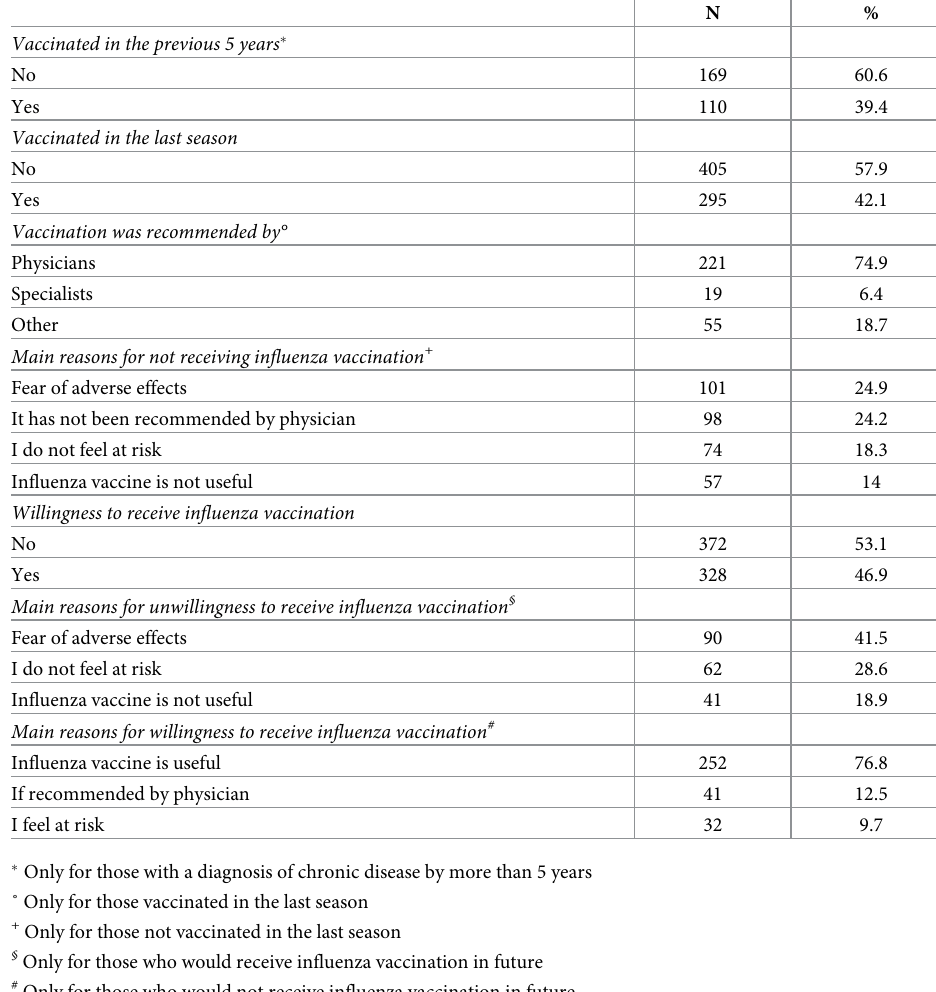
Table 3. History of influenza vaccination and willingness to receive